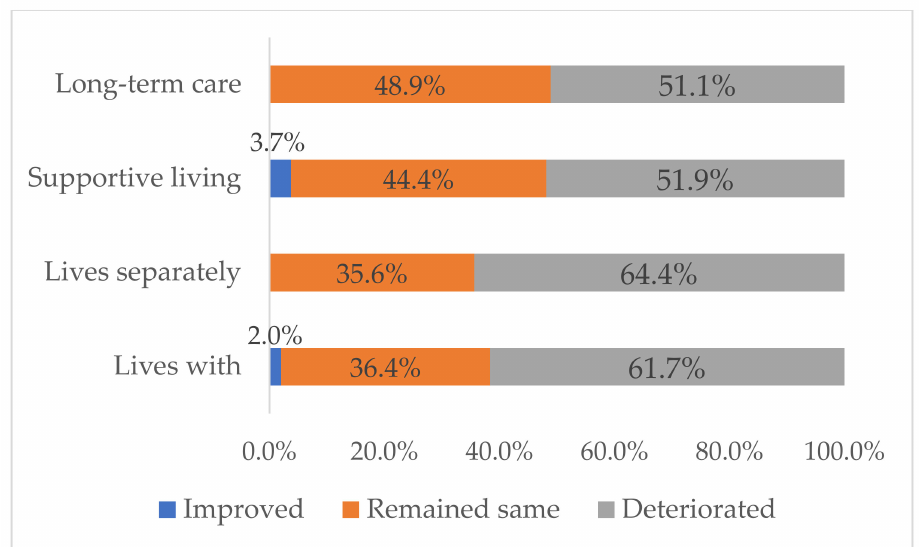
Figure 4. Caregiver’s Self-rated Changes in Mental Health.